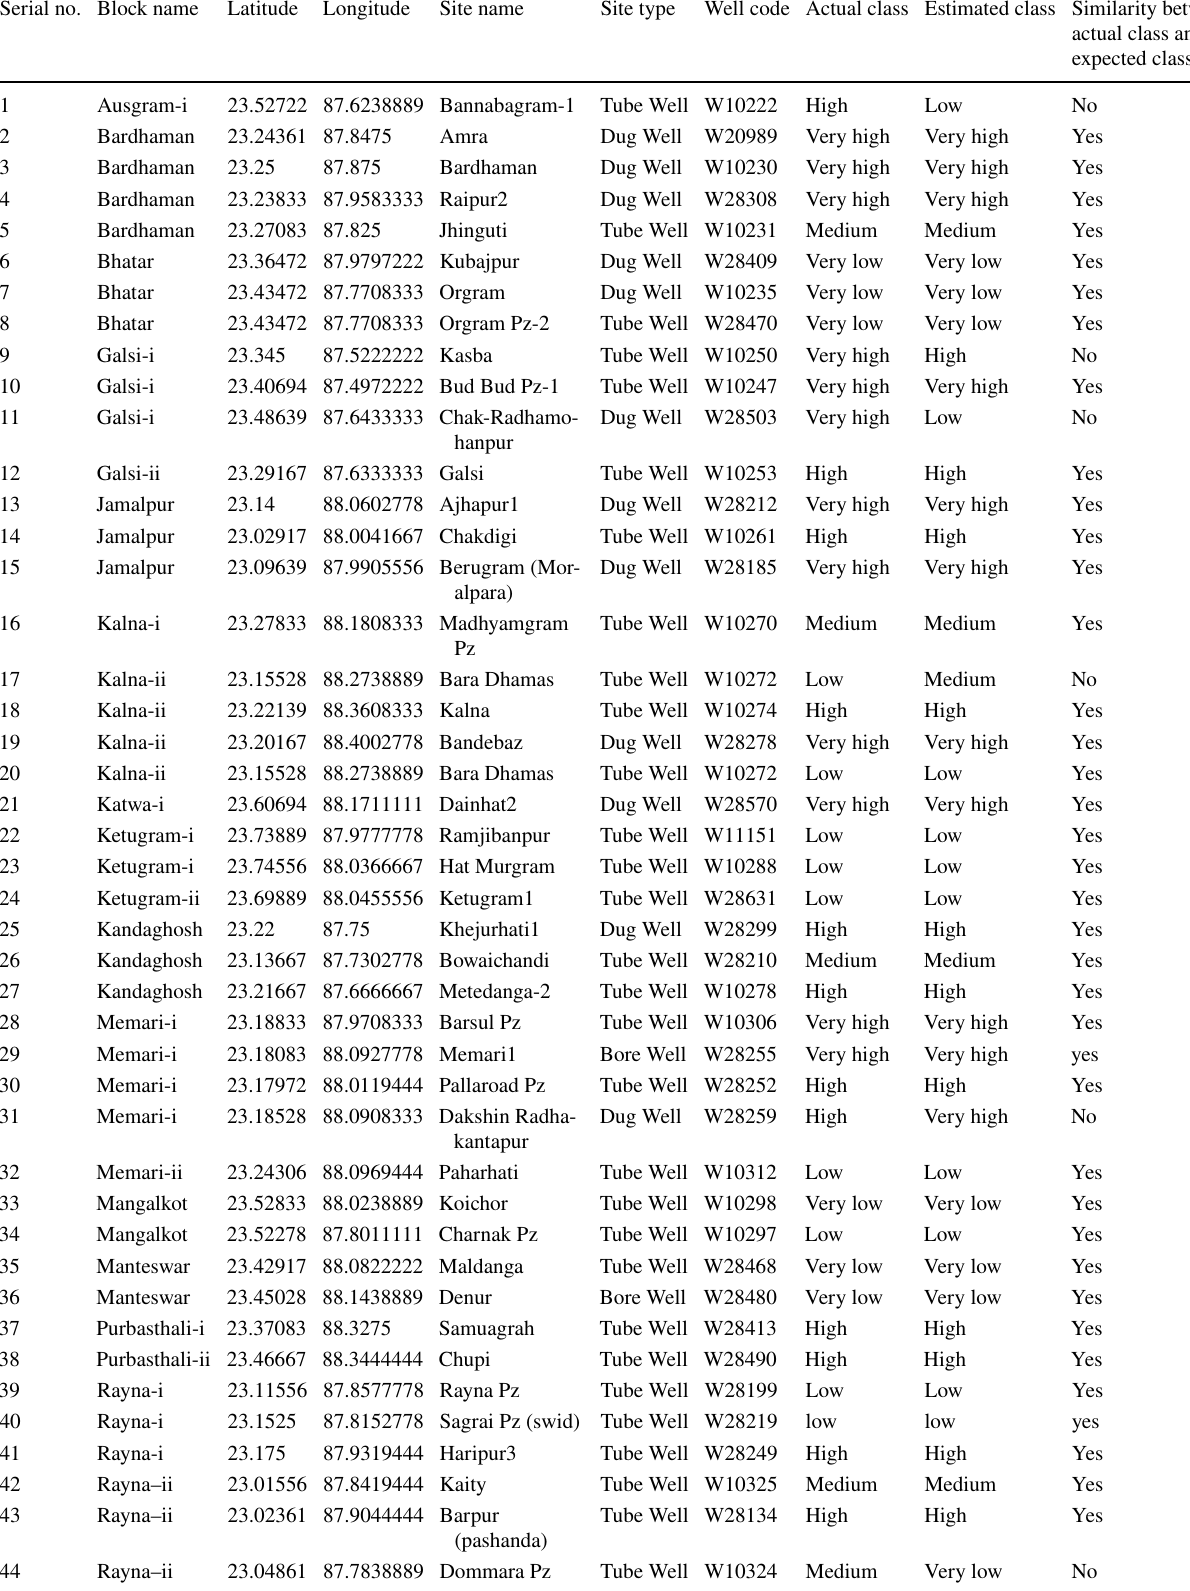
Table 6 Detail account of the validation